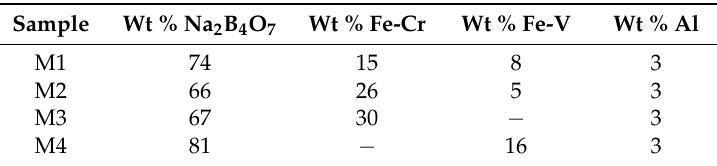
Table 1. Chemical composition of the salt